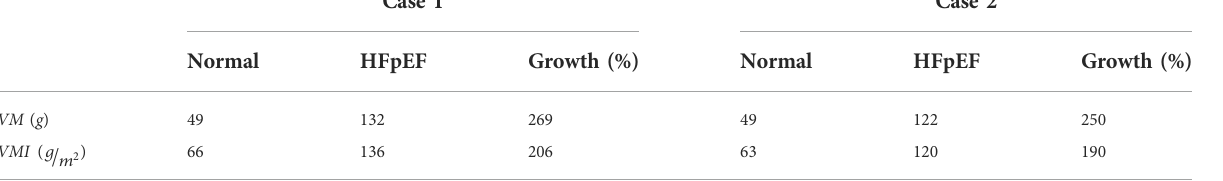
TABLE 3 Left ventricular mass properties before and after